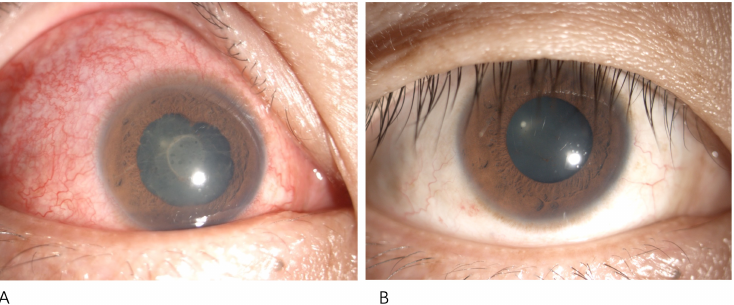
Figure 1. Iritis after administration of inactivated COVID-19 vaccine. The right eye of a patient presented with iritis 3 days following the first dose of inactivated COVID-19 vaccine ( A ). The patient was treated with topical and periocular steroid and the inflammation resolved at a 2-week follow-up ( B ). Case